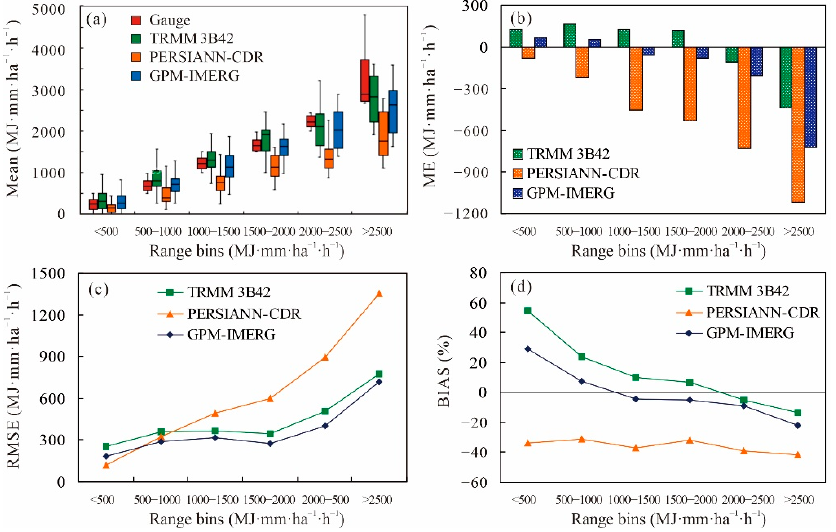
Figure 5. Distribution of the Mean ( a ), ME ( b ), RMSE ( c ), and BIAS ( d ) of rainfall erosivity in different intensity categories on the monthly scale.